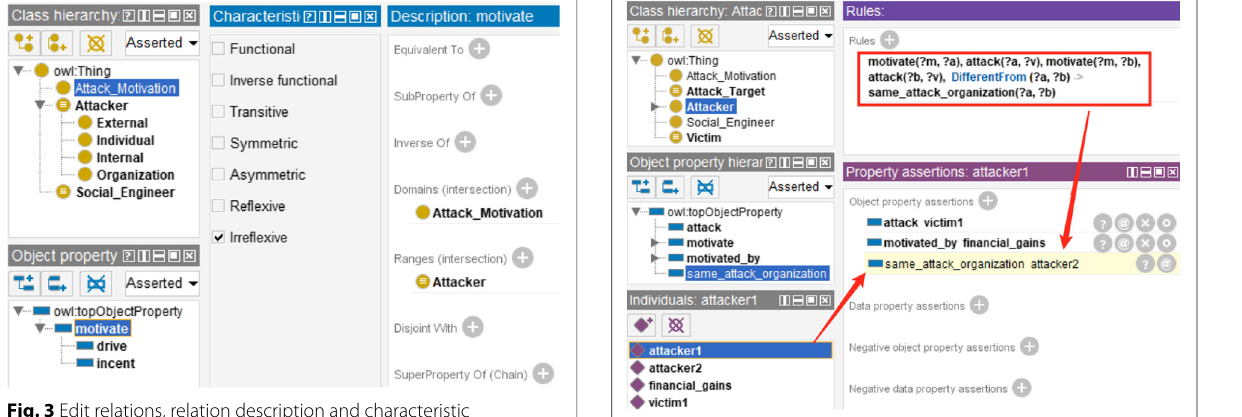
Fig. 4 Define and apply rules to knowledge reasoning